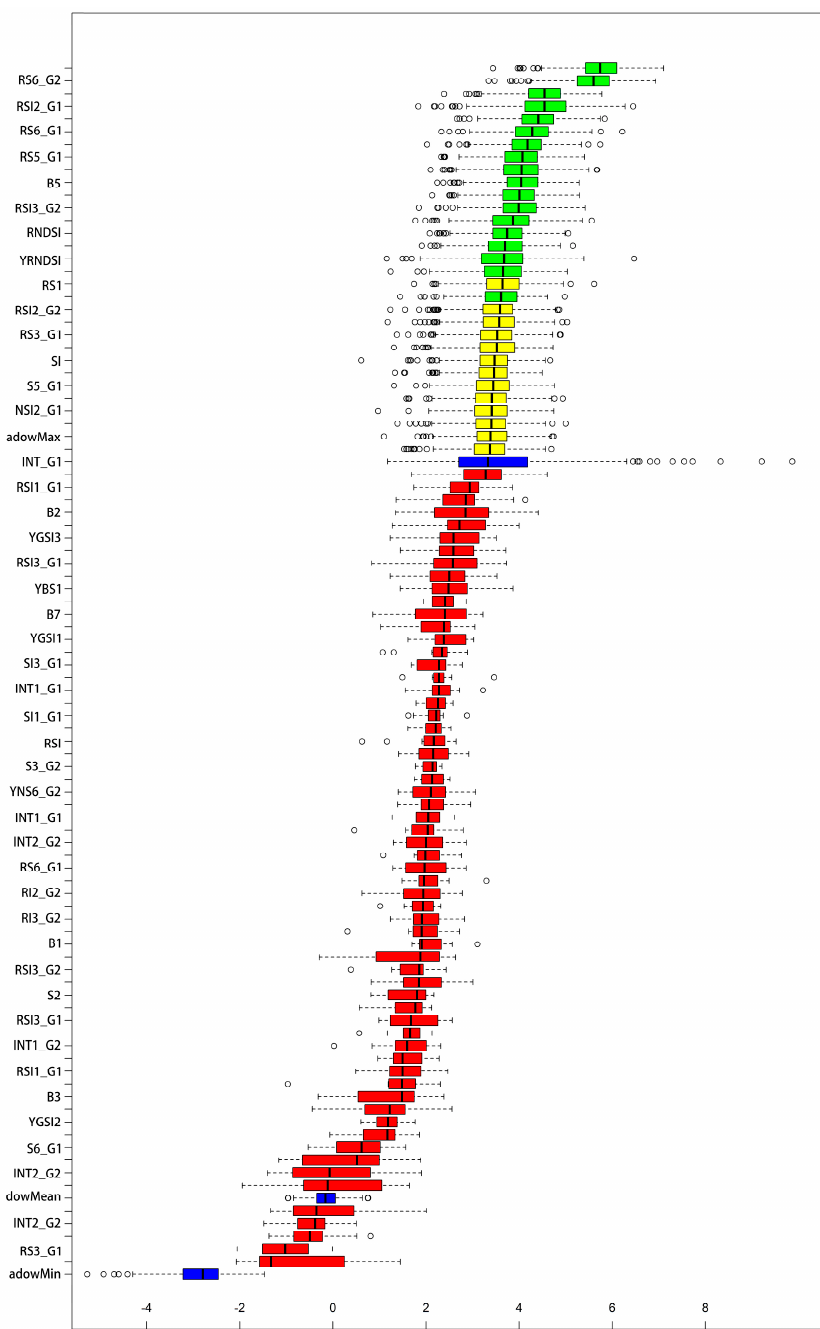
Figure 5. Boruta’s algorithm determines the importance of the existing and new salinity indexes. The blue variables are shaded features, the green variables are essential, the yellow ones are undetermined, and the red ones are